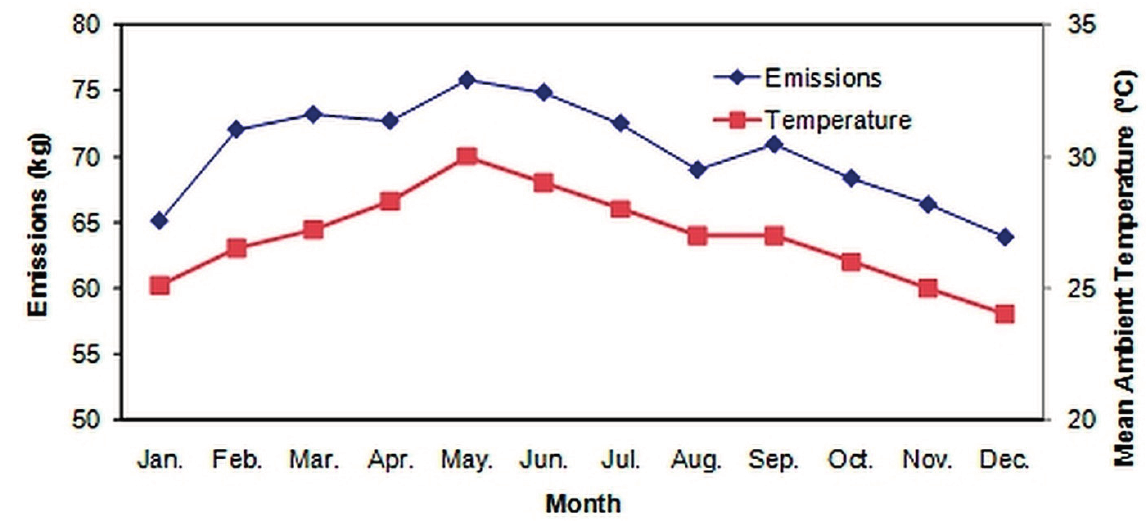
Figure 4. Monthly Variations of Hg Emissions from Power Plants versus Monthly Mean Ambient Temperature in Thailand.